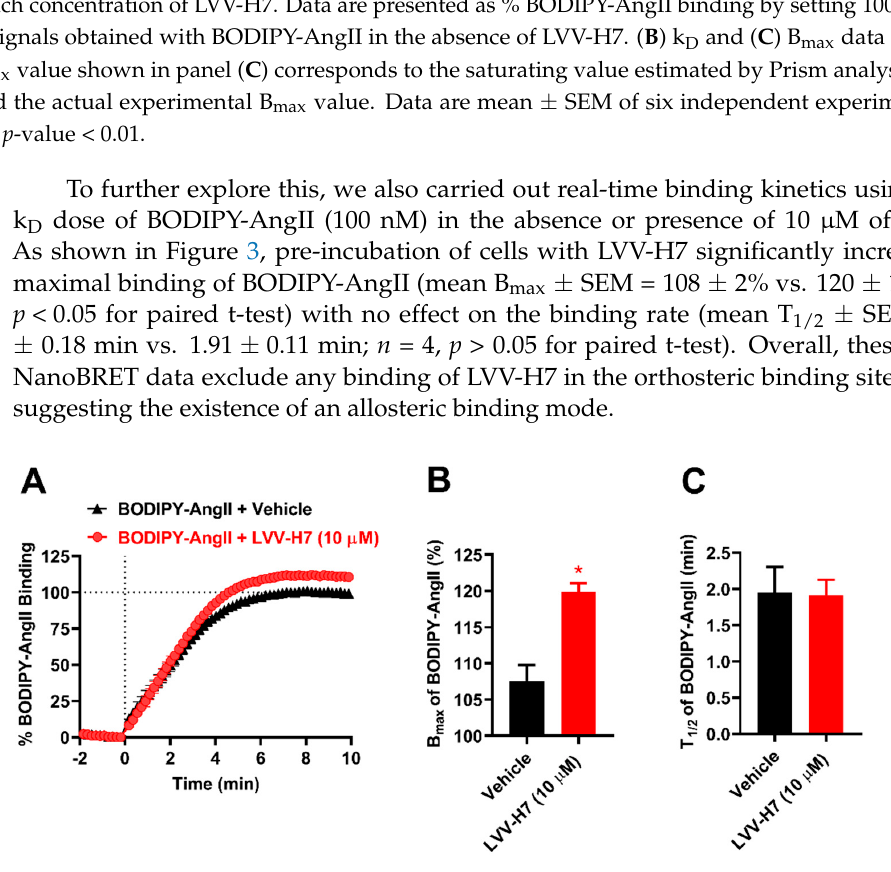
duplicate. * p -value < 0.05.